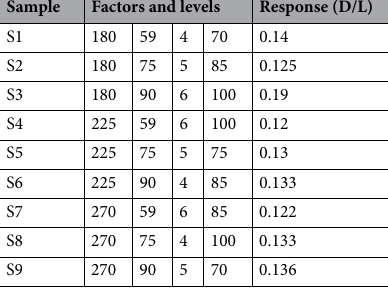
Table 4. The ratio of diameter to length measurements of Taguchi L 9 .